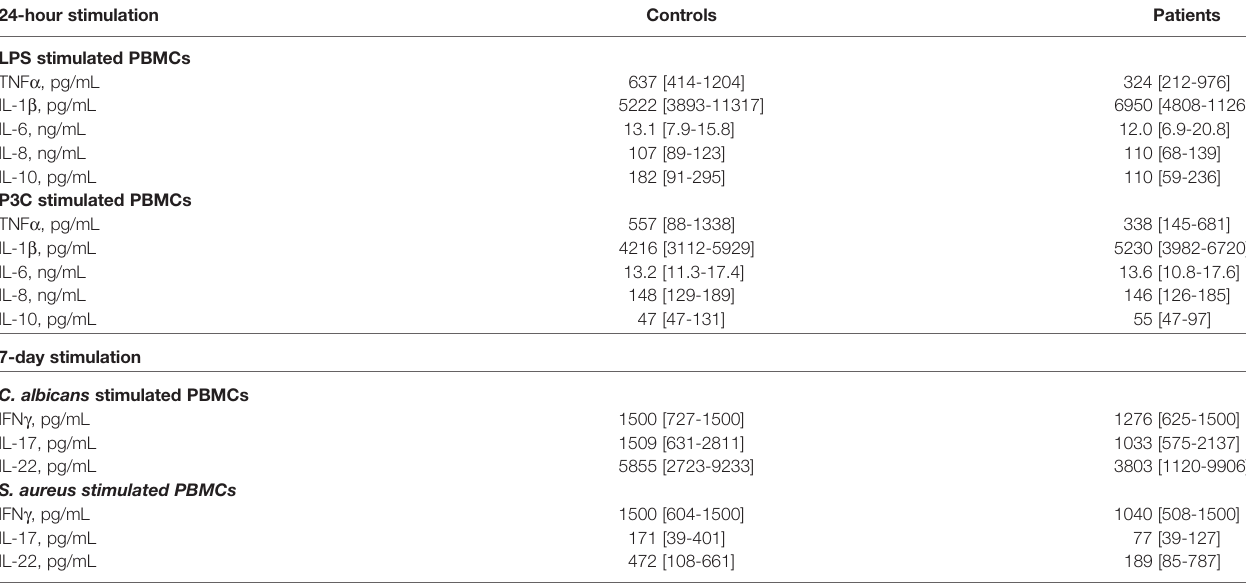
TABLE 3 | Cytokine production capacity.